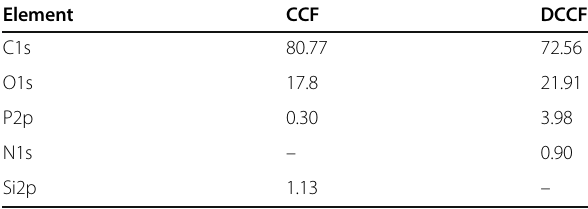
Table 2 Surface elemental composition (At%) of